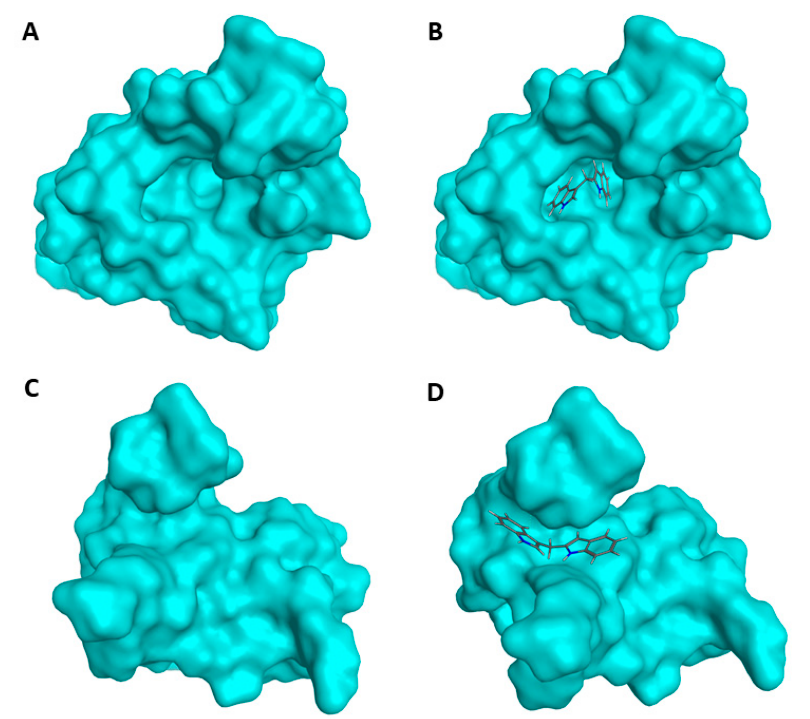
Figure 4. In-silico prediction of MDM2-DIM interaction. ( A ) N terminal structure (p53 binding site) of MDM2. ( B ) Molecular Operating Environment (MOE) software predicted interaction between DIM and the MDM2 N-terminal hydrophobic pocket. ( C ) C-terminal structure (Really Interesting New Gene (RING) domain) of MDM2. ( D ) MOE predicted the binding of DIM to the RING domain grove in MDM2.